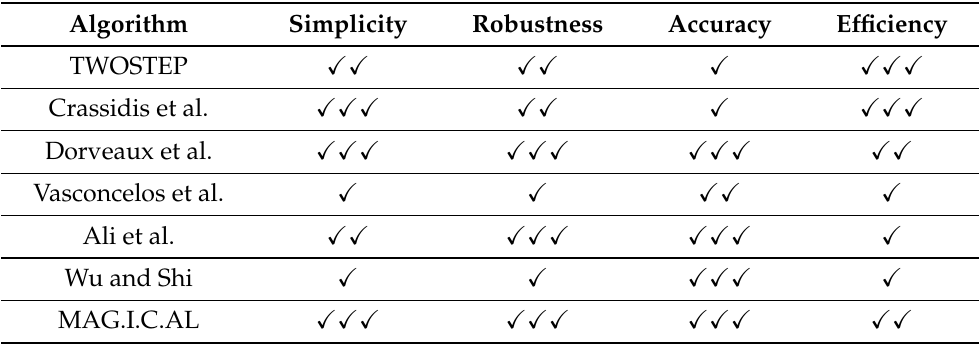
Table 4. Algorithms’ Comparison Summary – More checkmarks correspond to better performance regarding a specific